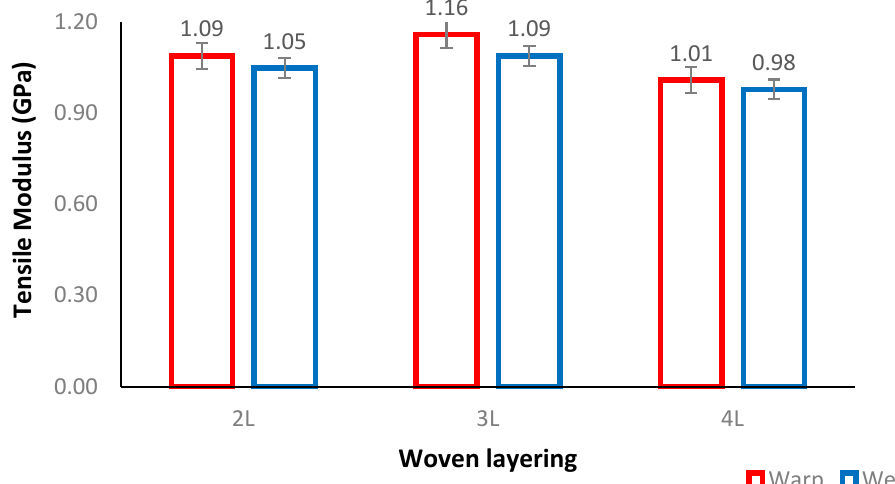
Figure 3. Tensile modulus of woven PALF-reinforced epoxy composite at different layering number and fibre orientations.